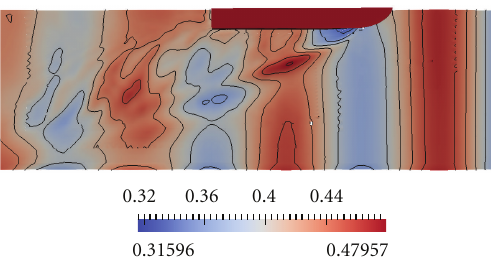
Figure 22: Isolines for free surface elevation of the ship in head waves.